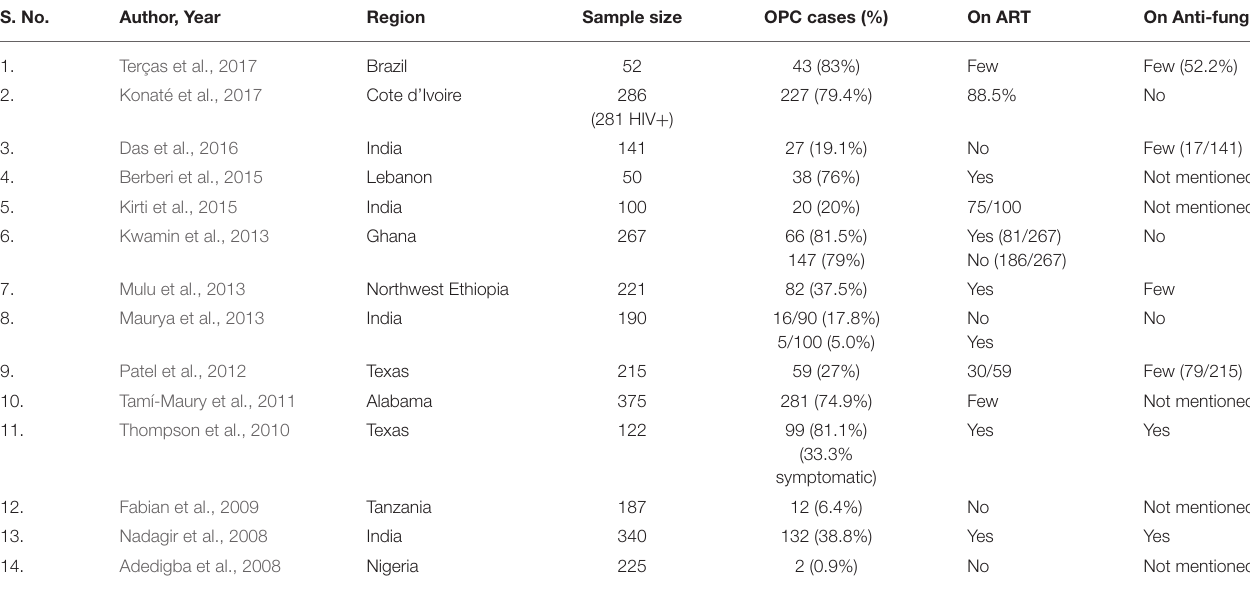
TABLE 1 | Occurrence of OPC in AIDS